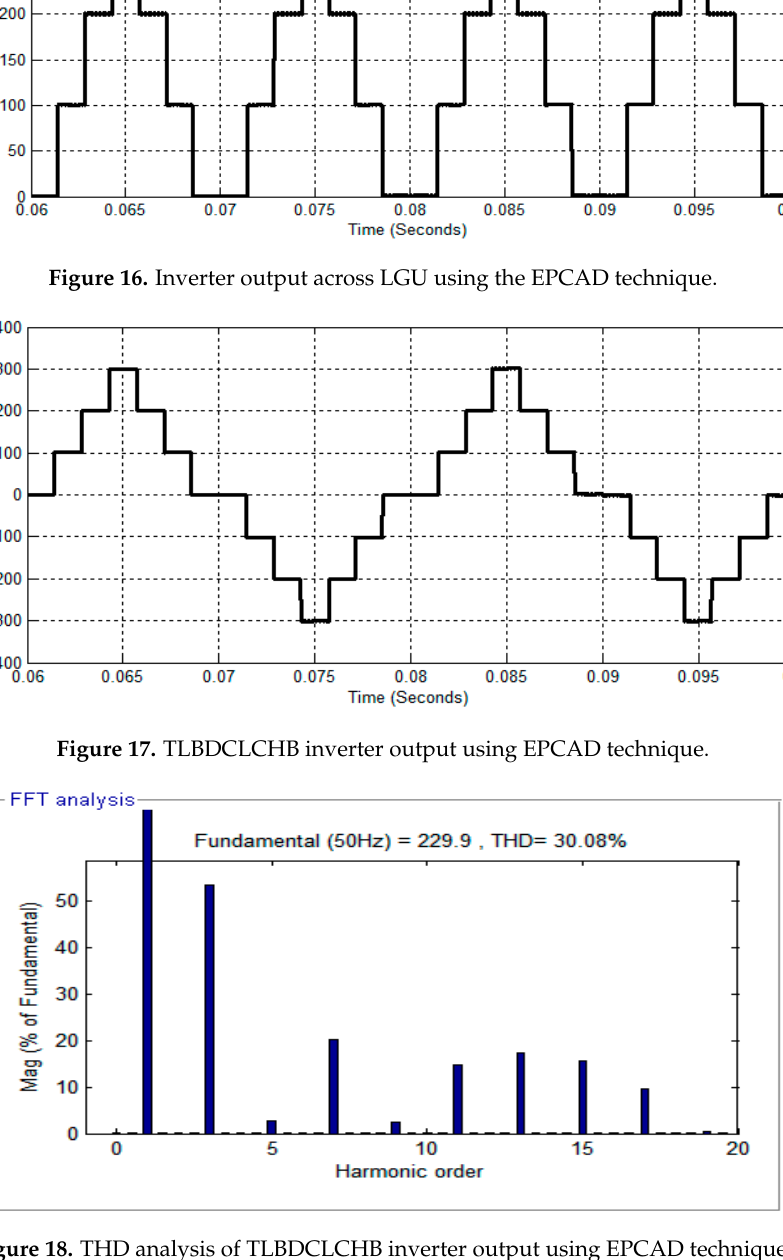
Figure 18. THD analysis of TLBDCLCHB inverter output using EPCAD technique.